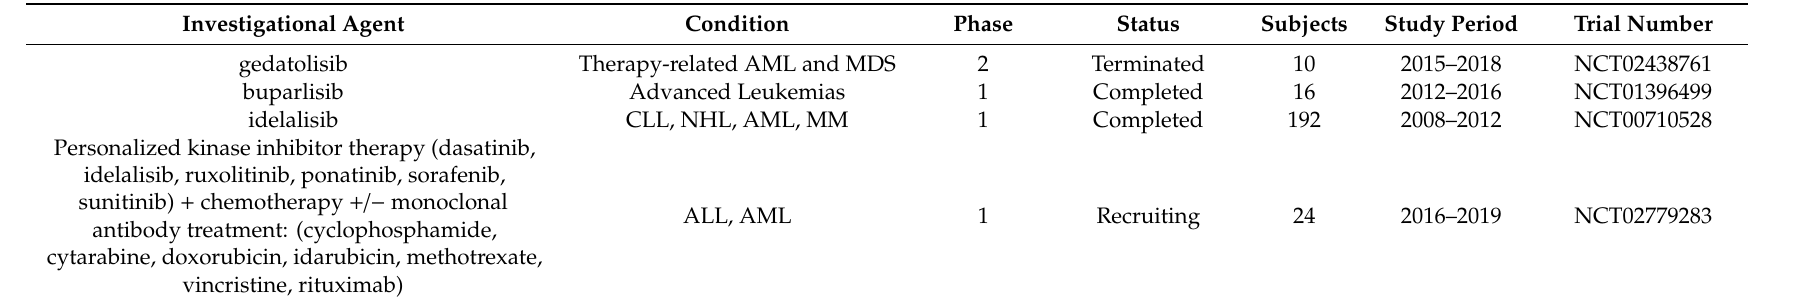
Table 2. Phase 1 / 2 clinical trials using PI3K / Akt / mTOR